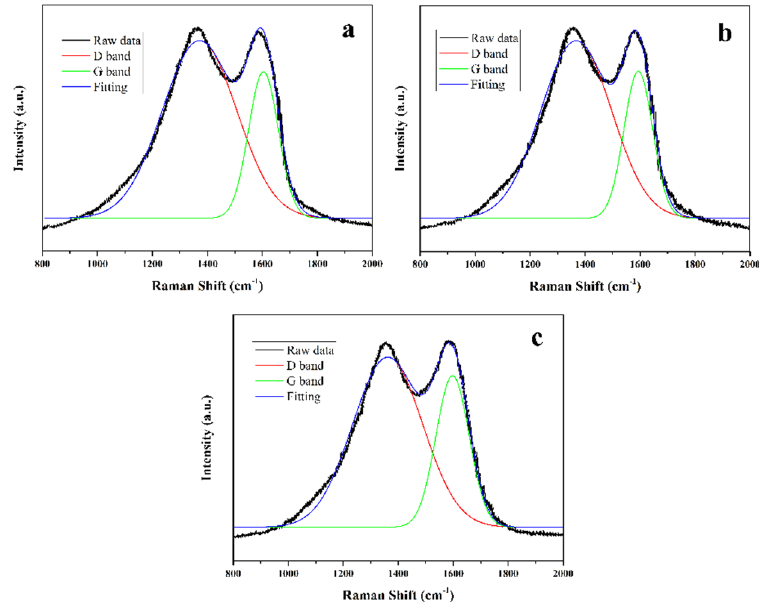
Figure 6. Raman spectra of ( a ) D20, ( b ) A20 and ( c ) A12D8 after cone calorimeter test.